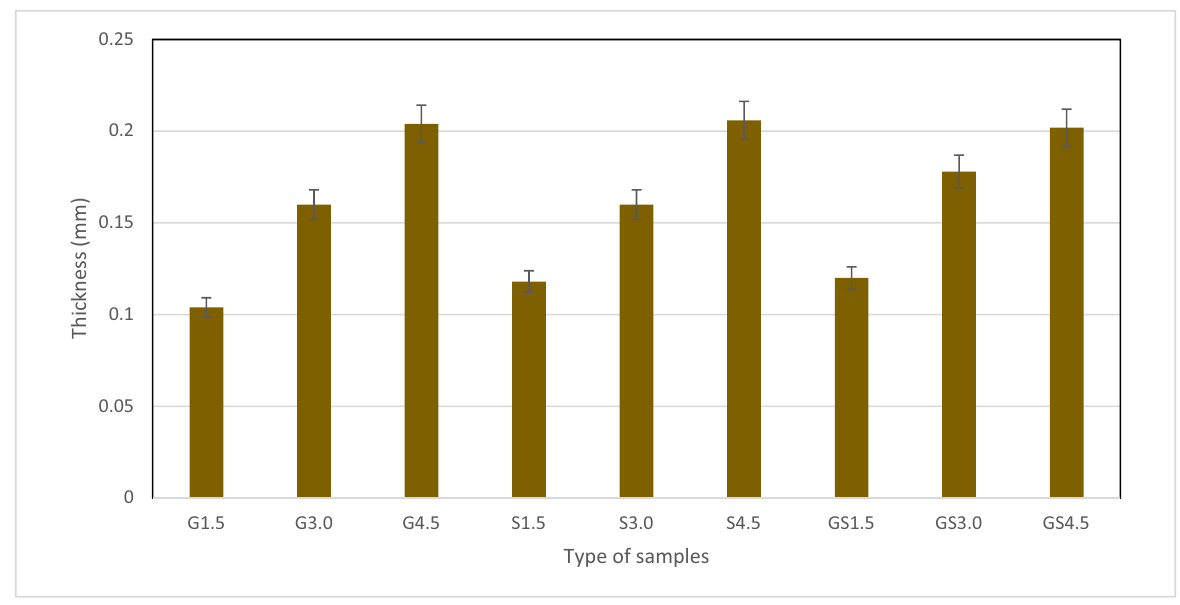
Figure 2: Thickness of the